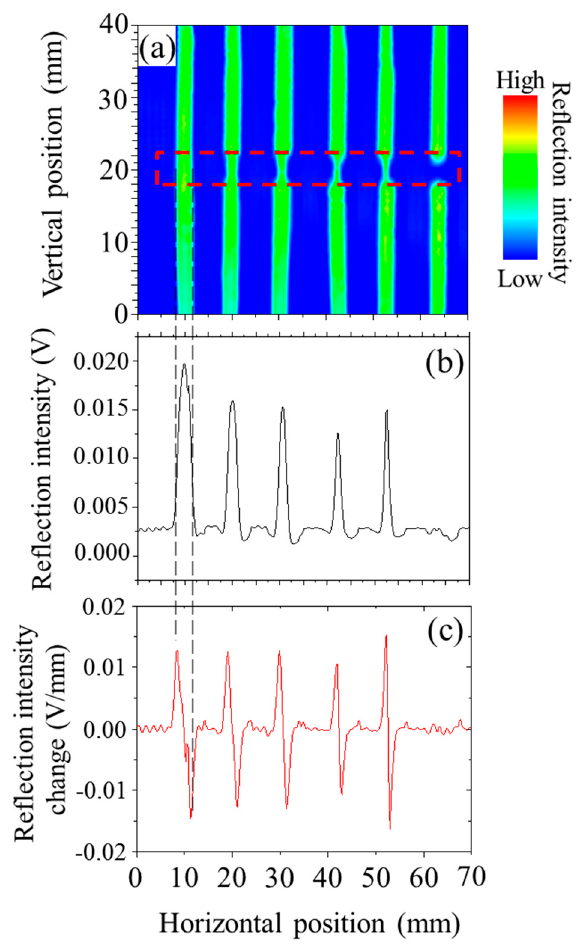
Figure 3. Quantitative analysis of imaging results: ( a ) THz imaging measurement result (the dotted line shows the defect part); ( b ) Reflection intensity in horizontal movement at the defect part; ( c ) Reflection intensity change in horizontal movement at the defect part.